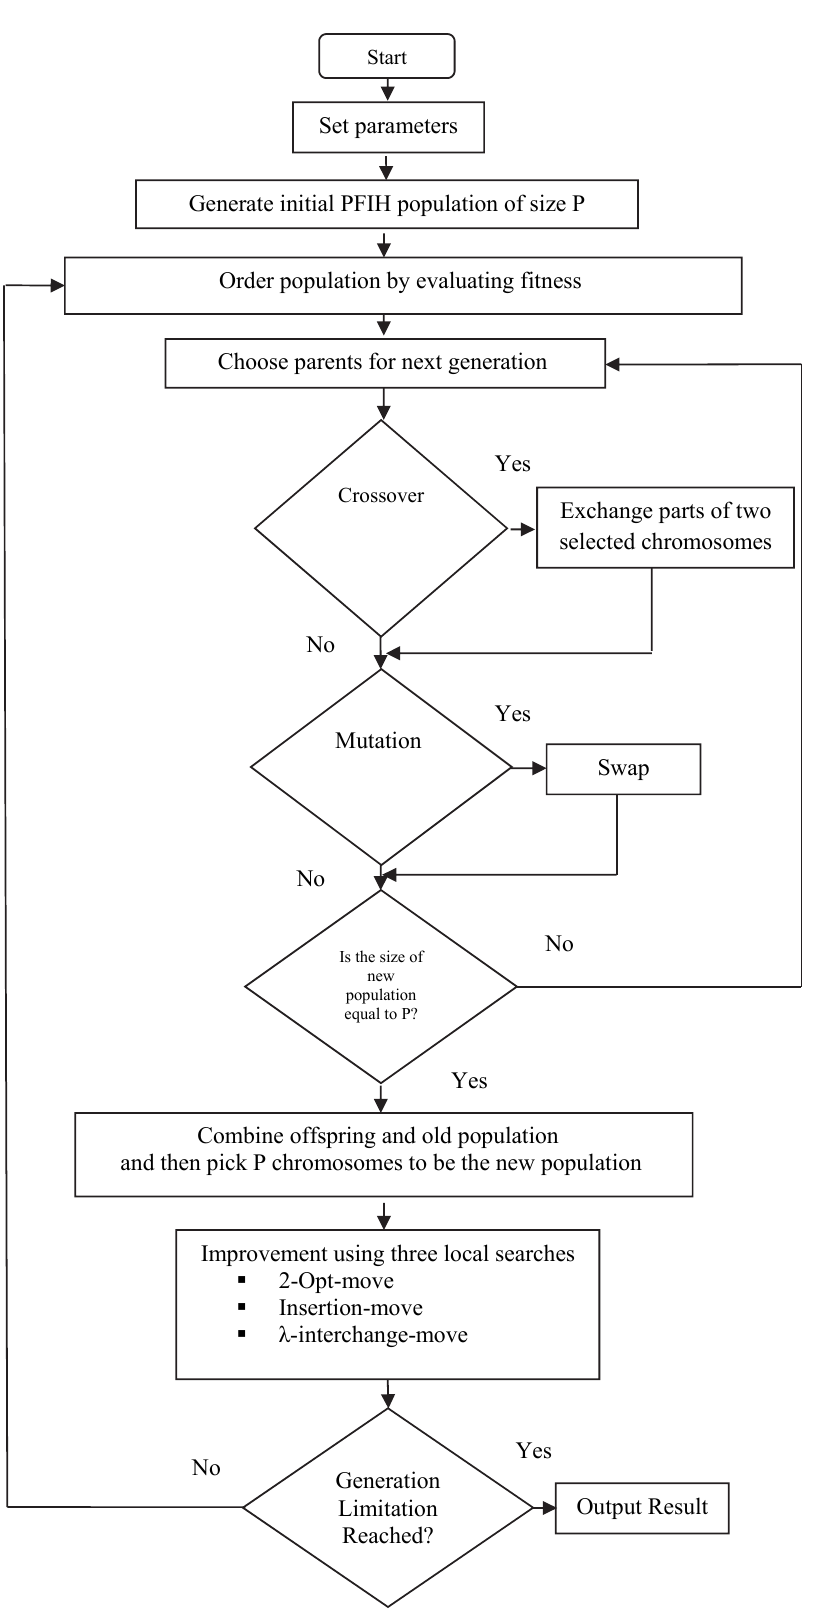
Fig. 4. Flow Chart of solution of VRP using